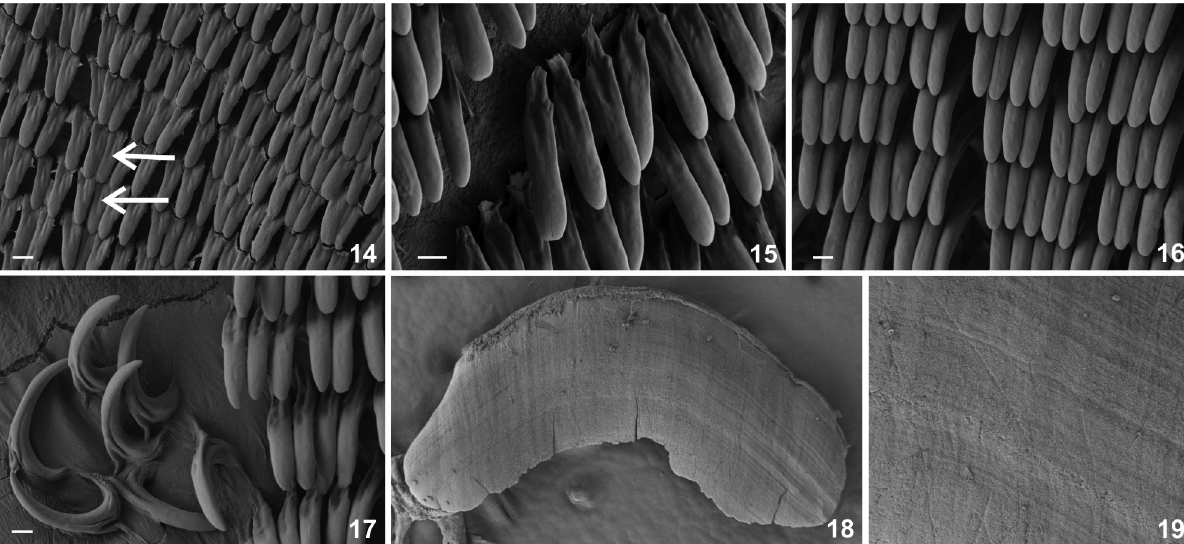
Figures 14–19. Digestive system: (14) Dorso-lateral view of the radula, arrows points to central tooth in two transverse rows of teeth; (15) detail on a dorso-lateral view of the lateral teeth;(16) detail of lateral teeth close to margin in dorsal view (17) margin of the radula showing curve shaped marginal teeth; (18) dorsal view of the smooth, fragile jaw; (19) detail of the dorsal surface of the jaw showing transversal shallow grooves. Scale bars = 10